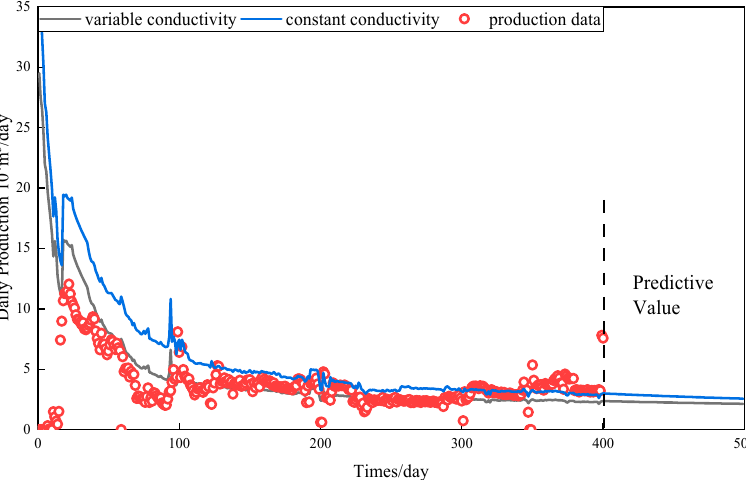
Figure 13. Comparison between actual production data and model prediction data of Well W1.